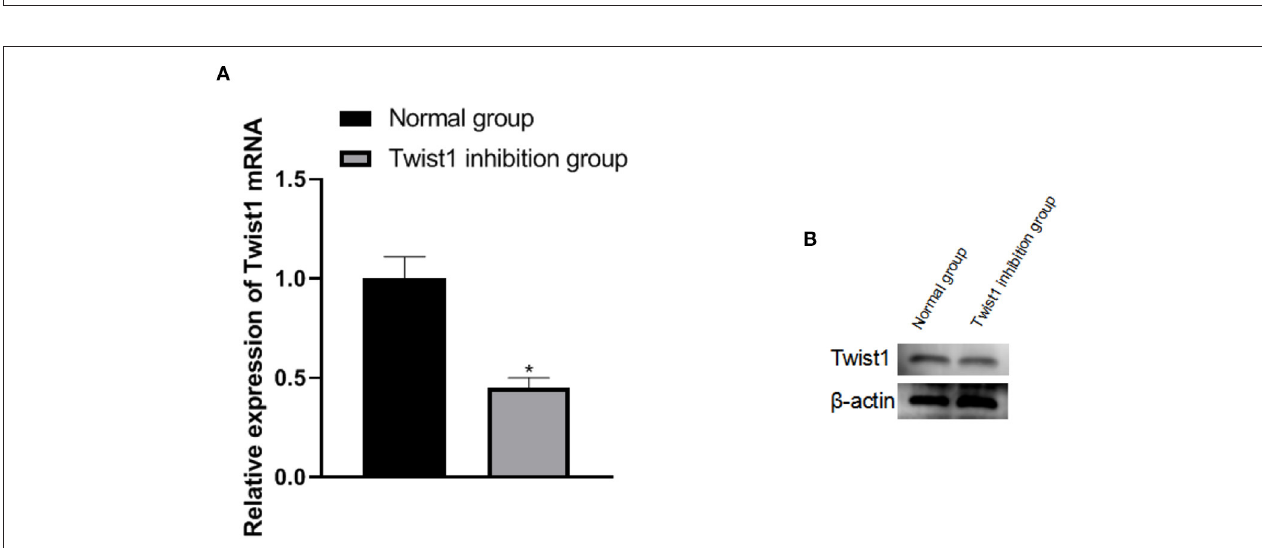
FIGURE 5 | The expression of Twist1 mRNA and protein in the placenta of two pregnant rats. (A,B) The expression of Twist1 mRNA and protein; Compared with Normal group, * p <